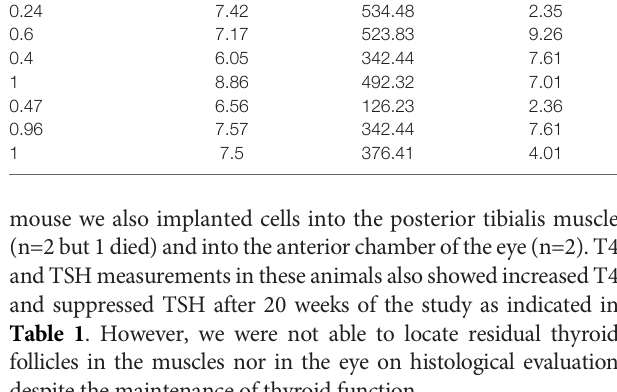
TABLE 1 | Individual thyroid function tests before and 20 weeks post implantation. Pre-implant T4 (µg/dL)